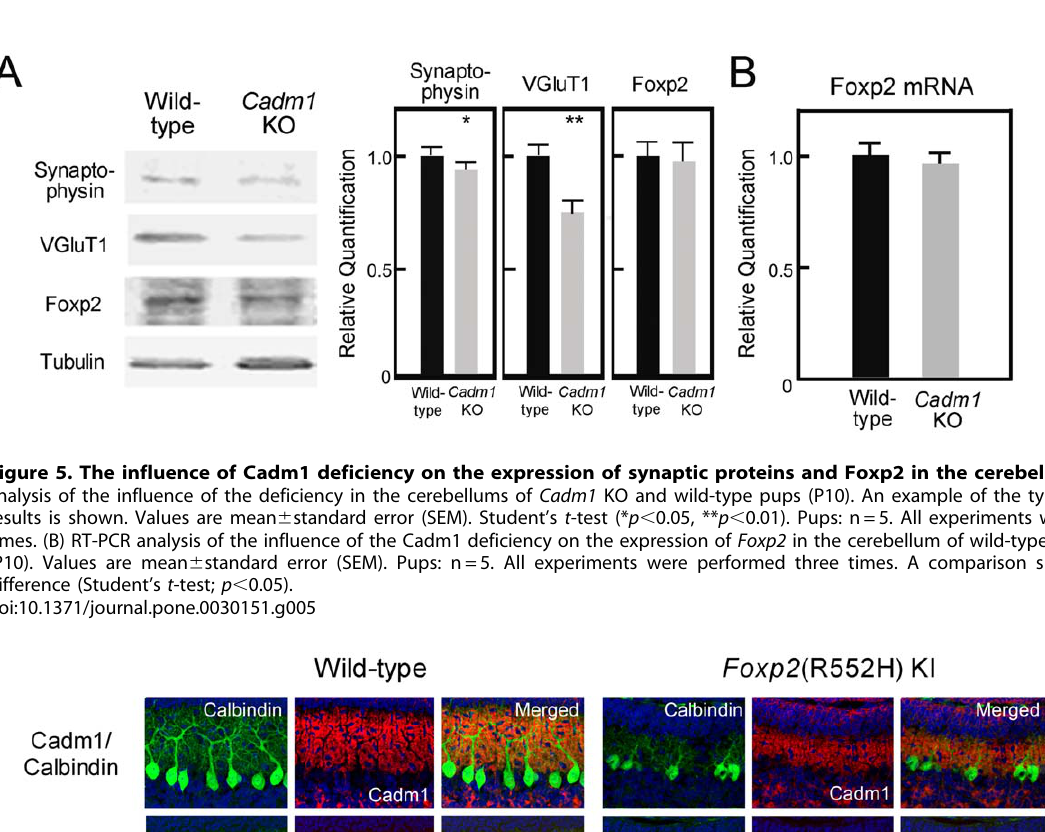
standard error (SEM). Student’s t -test (** p , 0.01). Pups: n= 3. Images: n =10. (TIF) Figure S3 RT-PCR analysis of the expression of Cadm1 in the cerebellum of wild-type and Foxp2 (R552H) KI mice (P10). Values are mean 6 standard error (SEM). Pups: n =5. All experiments were performed three times. A comparison showed no significant difference (Student’s t -test; p , 0.05). (TIF) Figure S4 The immunoreactivity (p11) of Synaptophysin (pre-synaptic marker) and PSD-95 (post-synaptic mark- er). Green, Cadm1. Red, Synaptophysin or PSD-95 (Cell Signaling Technology). Blue, Hoechst. Bar, 30 m m. (TIF)